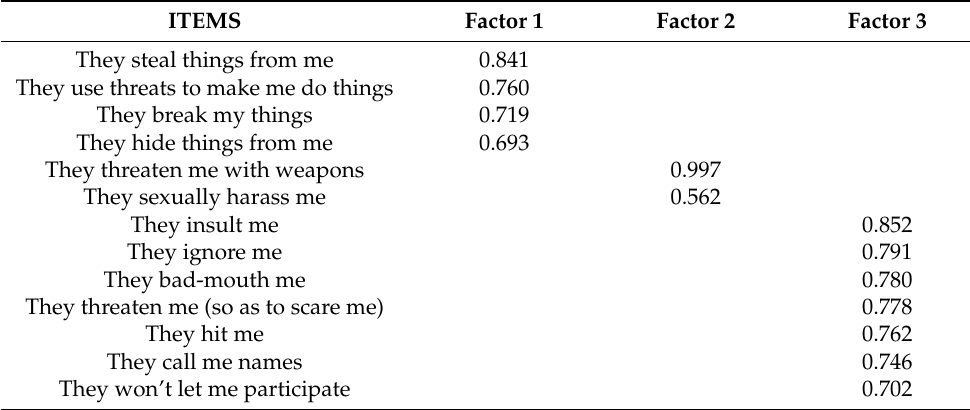
Table 4. Structure matrix of the bullying detection scale.